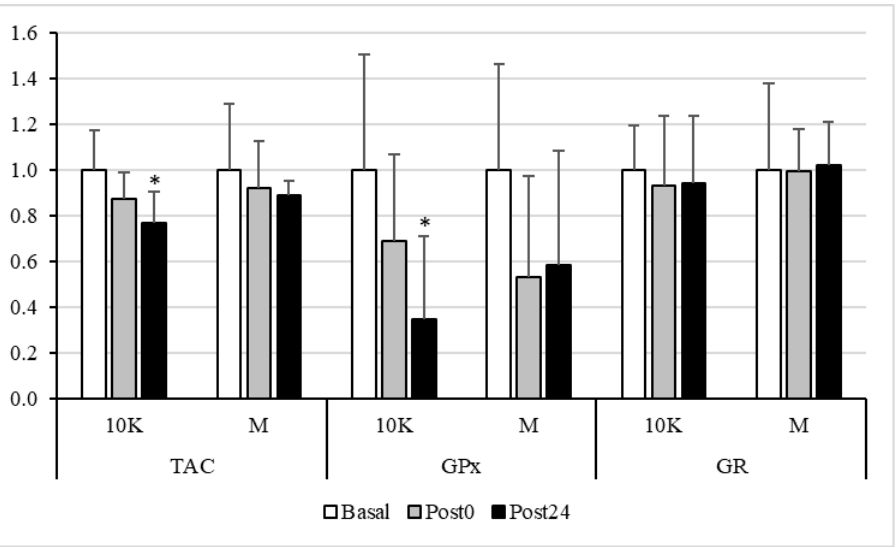
Figure 3. Total antioxidant capacity (TAC), Glutathione Peroxidase (GPx) and Glutathione reductase (GR) activities, expressed as fold over Basal, trough the different races and timepoints. 10K: 10 km race; M: Marathon race. Basal: sample collected within 1 h before each race; Post0: sample collected within 10 min after the race; Post24: sample collected 24 h after Basal. * Significantly different ( p < 0.05) from Basal and Post0. Data are presented as mean ± standard deviation. Sample size, N = 9.